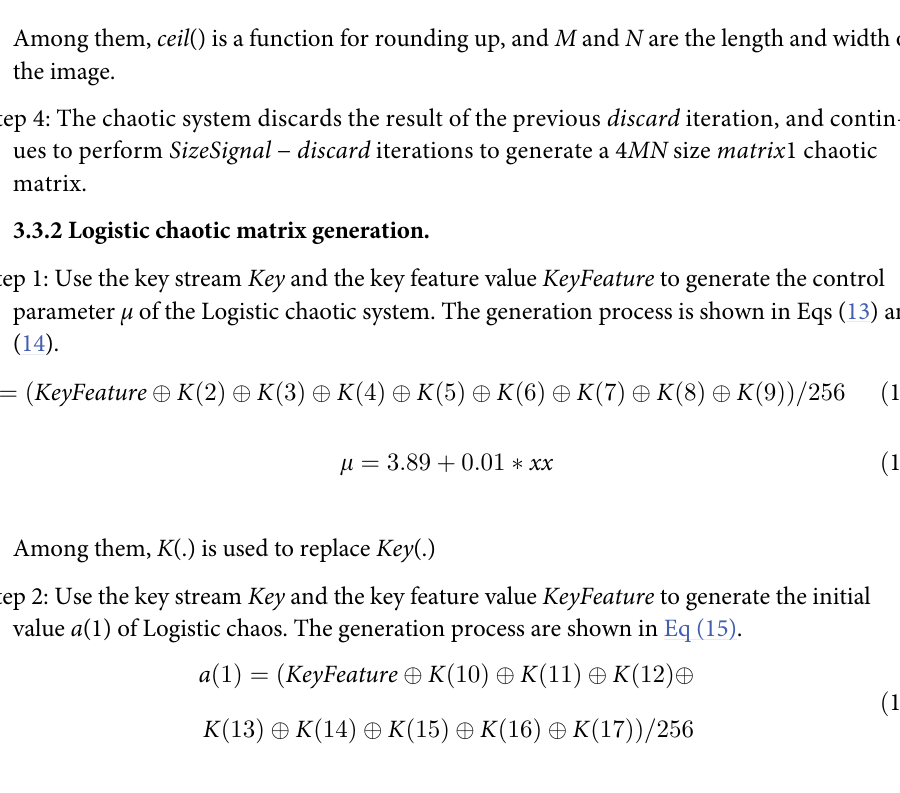
KeyMatrix ¼ matrix 1 ð 17